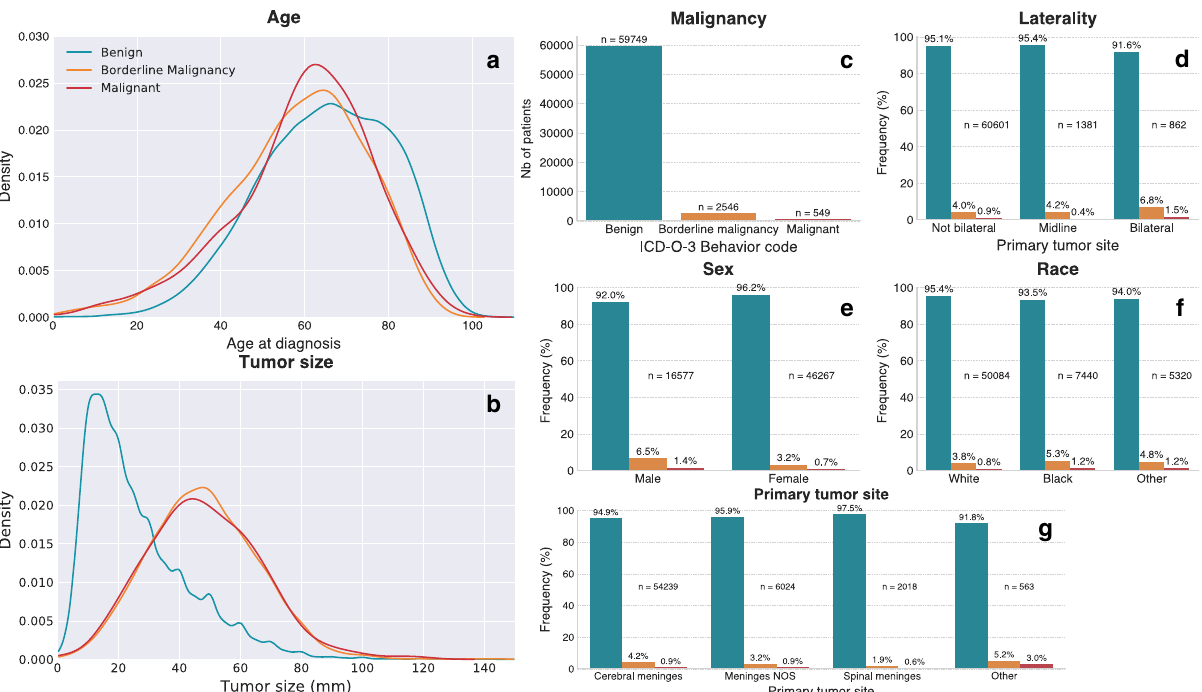
Fig. 1 Descriptive statistics for the malignancy outcome variable. Kernel density plots illustrate the distribution of benign, borderline malignant, and malignant meningiomas according to age at diagnosis ( a ) and tumor size ( b ). These kernel density plots are conceptually equivalent to histograms, but illustrate density (i.e., relative number of patients) as a continuous function of age/tumor size. Total number of meningiomas by WHO ICD-O-3 behavior codes are shown in c . Absolute numbers and percentages of patients with benign, borderline malignant, and malignant meningiomas by subgroup are shown for laterality ( d ), sex ( e ), race ( f ), and primary tumor site ( g